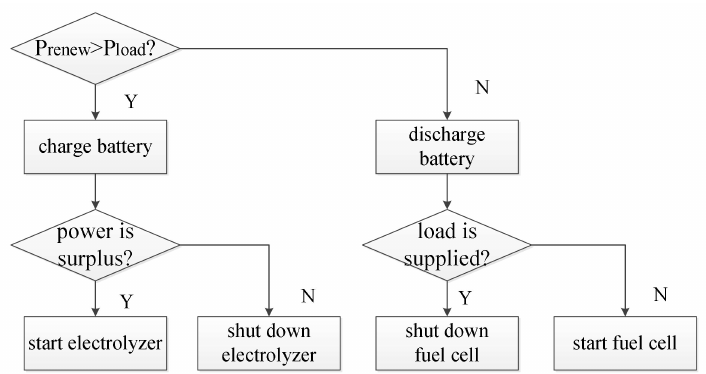
Figure 25. Traditional operation